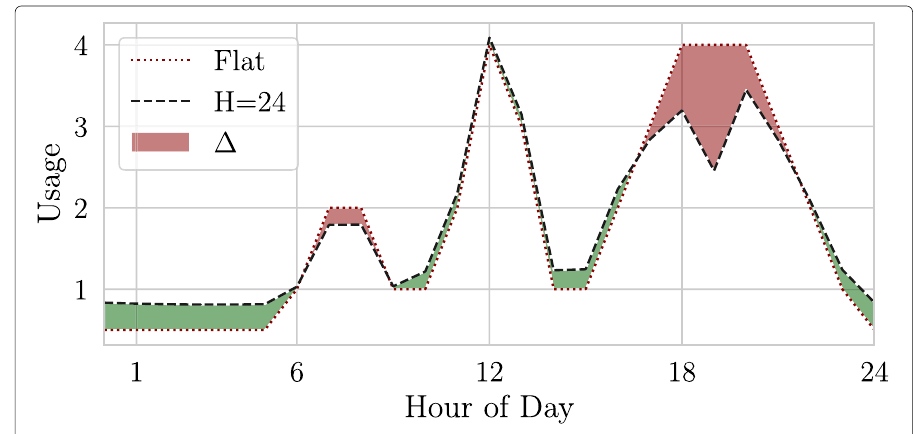
Fig. 10 Usage shifting under the optimally priced 24-hour horizon